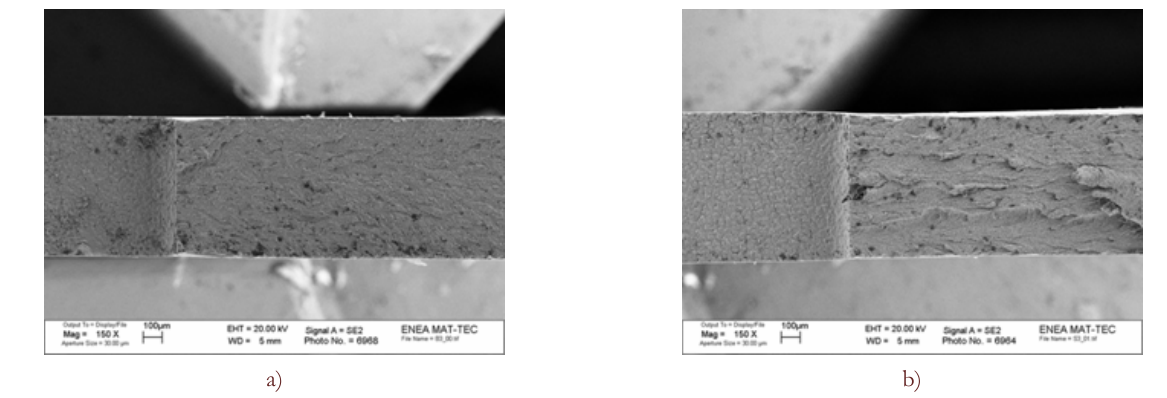
Figure 10: SEM observation of the fracture surface: a) reference and b) welded specimen [7].